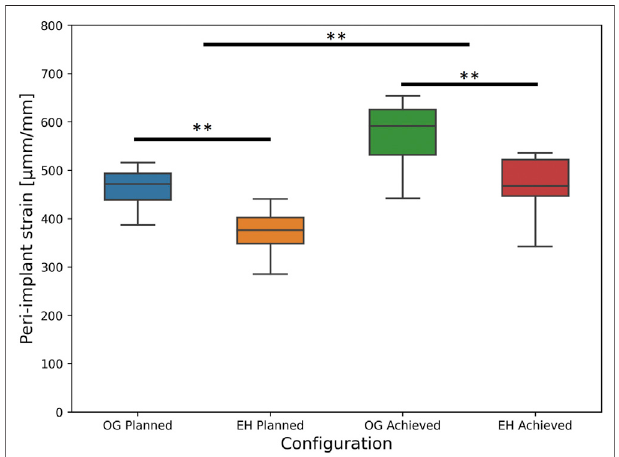
FIGURE7| FE-basedperi-implantbonestrainresults,i.e.,predictedrisk of cut-out failure, for the planned (left) and achieved (right) model types, with the latter exhibiting signi fi cantly higher values versus the former; signi fi cant differences between the OG and EH screw con fi gurations are demonstrated within each separate (planned or achieved) model type (**: p ≤ 0.01).